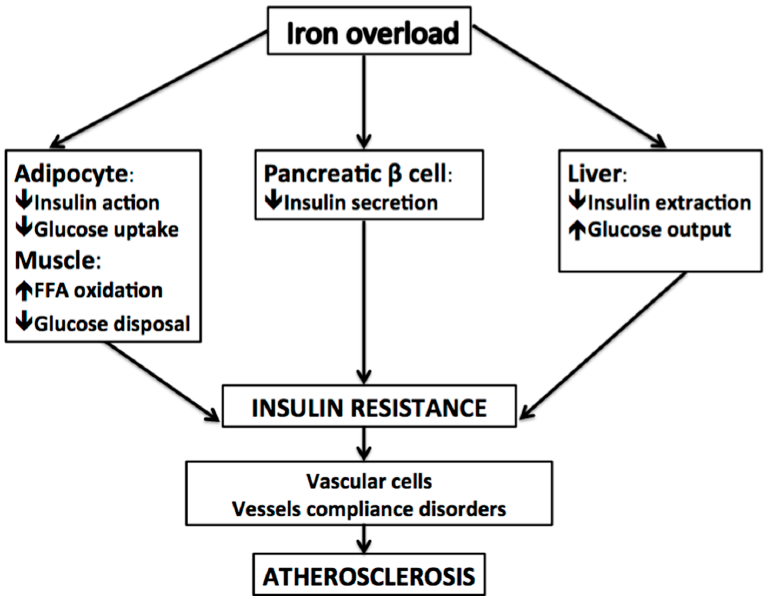
Figure 2. Effect of dietary iron overload on metabolic alterations, insulin resistance, and atherosclerosis. The downward arrows mean decrease and upward arrows mean increase. FFA: free fatty acid.